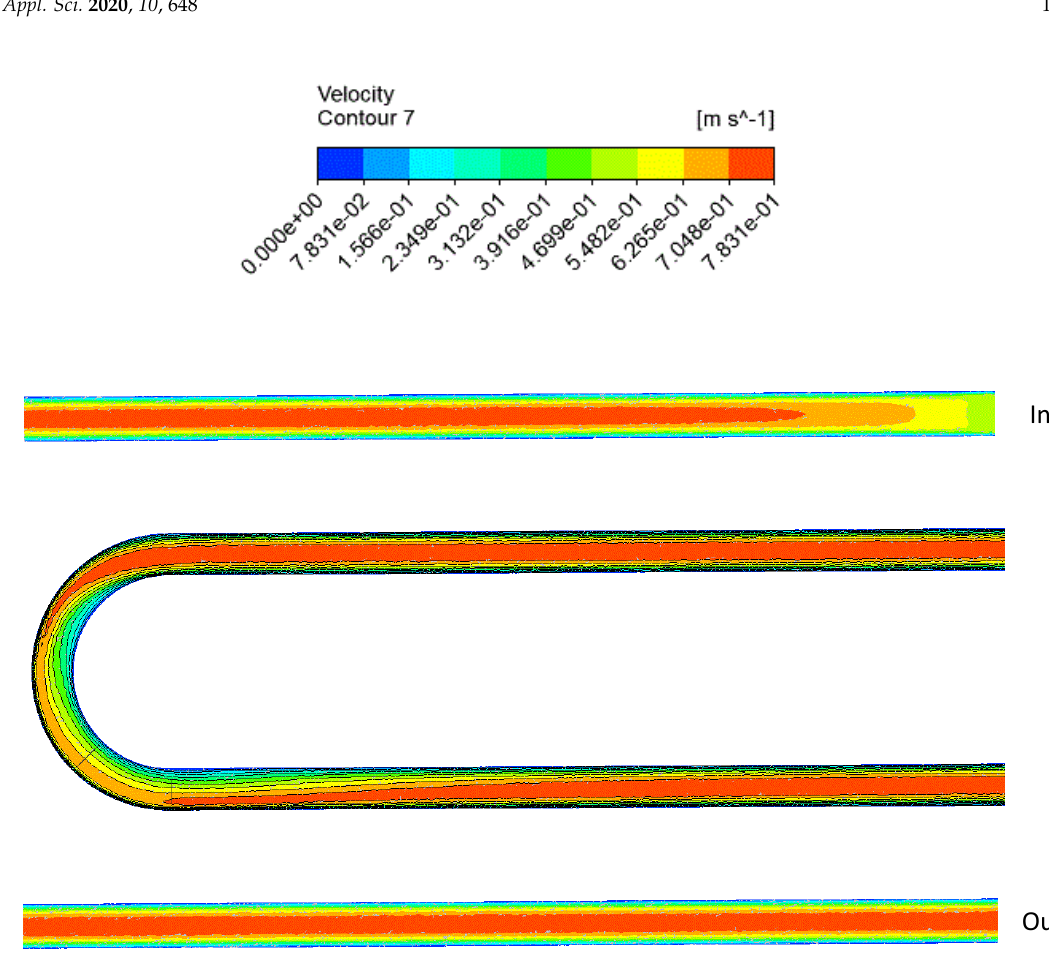
Figure 11. Velocity magnitude contour distribution along the inlet, curvature, and outlet sections using fruit